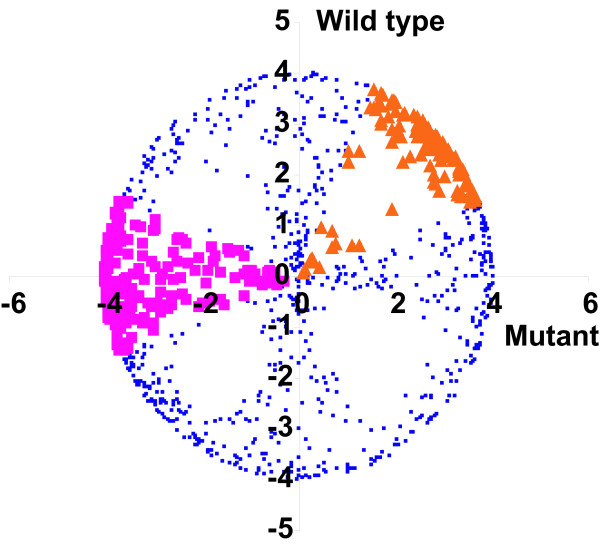
Vector analysis of gene expression responses in two genetic backgrounds in Arabidopsis plants. Each dot corresponds to a single sum vector from four pairwise comparisons (two replicates per background). Genes towards the periphery of the circle show the most consistent behavior among replicates. Two behavior prototypes are highlighted (corresponding to Gene 1 and 2 in Fig. 1), mutant-specific down-regulation (purple) and WT/Mutant-consistent up-regulation (orange). It can be seen that inconsistent genes (close to the center) are generally showing background-specific responses, i.e. they are enriched along the axes of the plot. Their behavior is most likely the result of spurious noise in a single replicate.